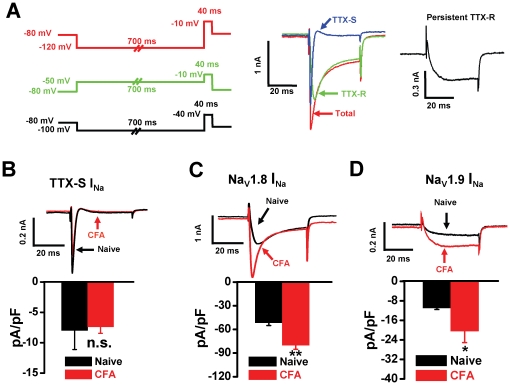
Distinct changes in three components of sodium currents following CFA treatment.(A) Identification of different components of sodium current through electrical stimulus protocols. The total current (red) was recorded with a 700 ms hyperpolarizing prepulse (from −80 mV to −120 mV) followed by a test pulse (40 ms, −10 mV). The TTX-R NaV1.8 sodium current (green) was recorded with a 700 ms depolarizing prepulse (from −80 mV to −50 mV) followed by a test pulse (40 ms, −10 mV). The TTX-S sodium current (blue) was obtained by digital subtraction of the TTX-R current from the total current. TTX-R NaV1.9 persistent sodium current (black) was recorded with a 700 ms hyperpolarizing prepulse (from −80 mV to −100 mV) followed by a test pulse (40 ms, −40 mV). After CFA treatment, the density of TTX-S sodium current (B) was not changed (n = 6). Whereas the densities of TTX-R sodium currents of NaV1.8 (C) and NaV1.9 (D) were increased by 55% and 87% (n = 6–8), respectively. CFA, complete Freund's adjuvant. * p<0.05; **p<0.01.